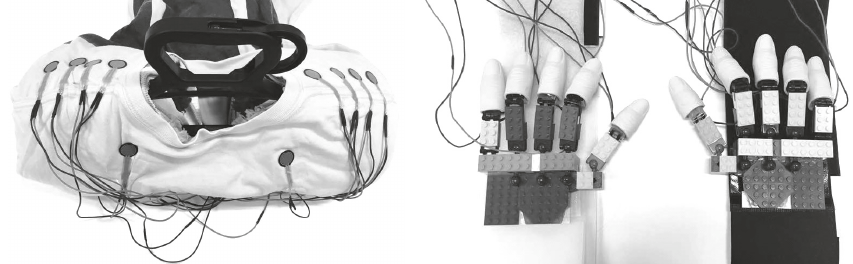
Figure 2: Sender device (left) and receiver device (right).